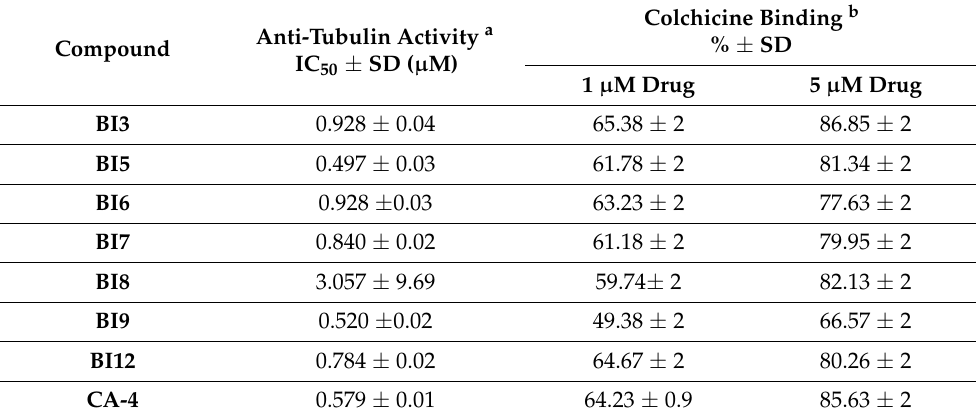
Table 2. Inhibition of tubulin polymerization and colchicine binding by benzotriazole compounds and